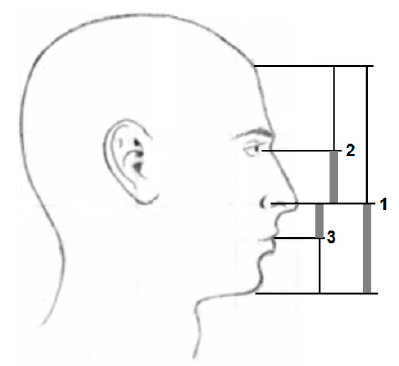
Figure 13. Face proportionality divided in the golden section.